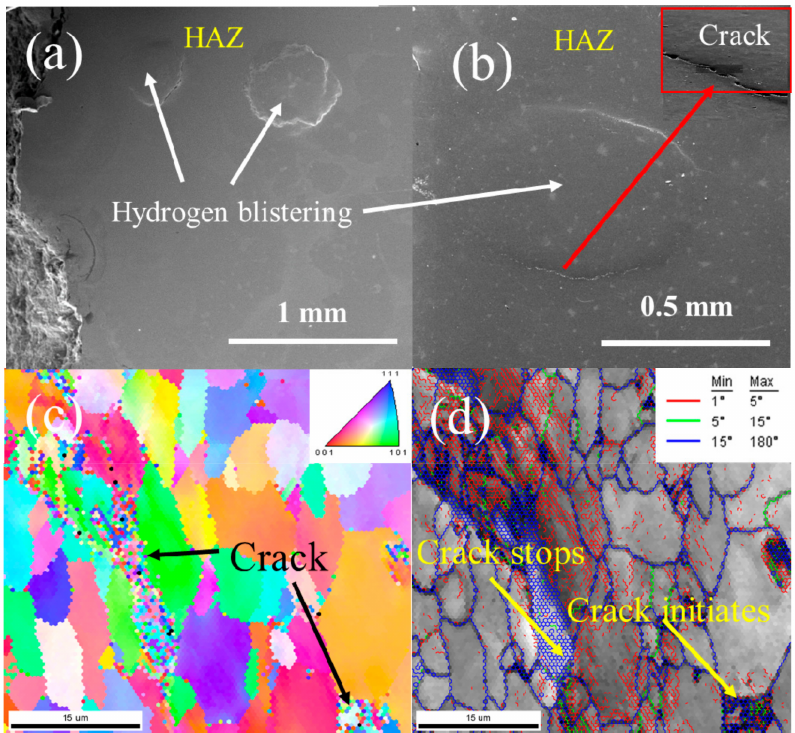
Figure 10. Hydrogen blistering and a crack on the surface of the HAZ samples after tensile tests at a current density of 40 mA / cm 2 : ( a , b ) SEM image of the hydrogen blistering; ( c ) IPF map of the crack, and ( d ) IQ maps with the grain boundary misorientation distribution of the